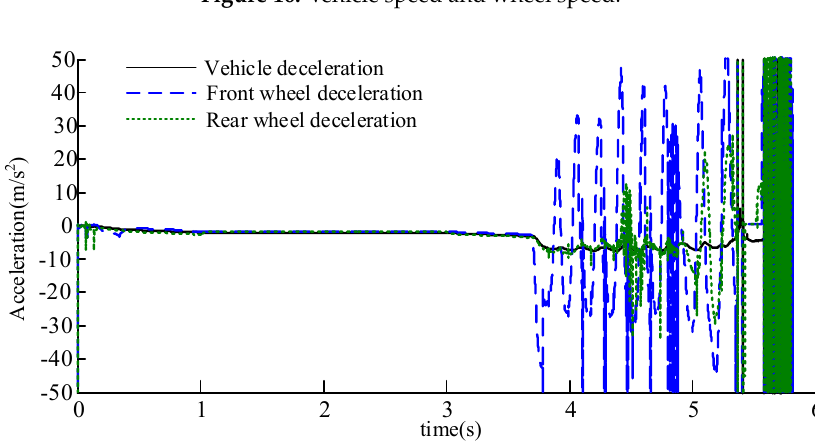
Figure 16. Vehicle speed and wheel speed.